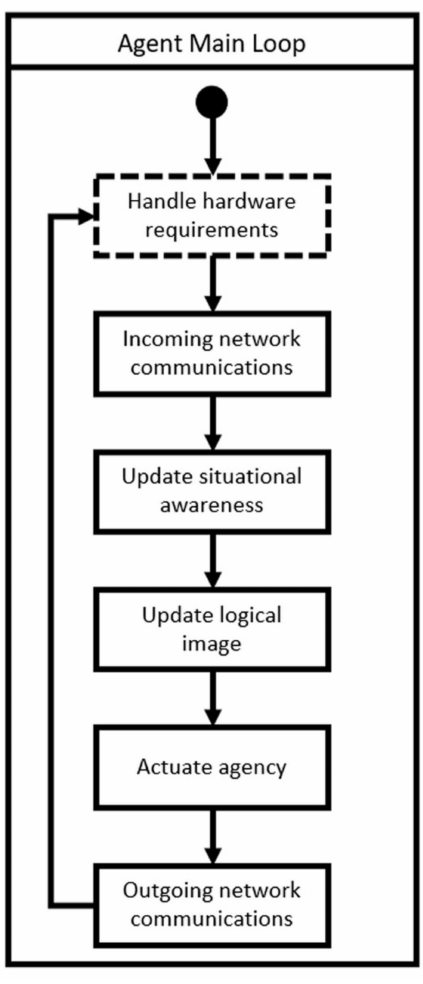
Figure 2. The general software architecture of an ITM-compatible